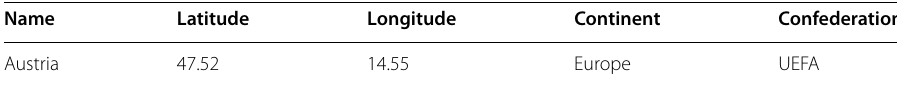
Table 3 Example record of the country